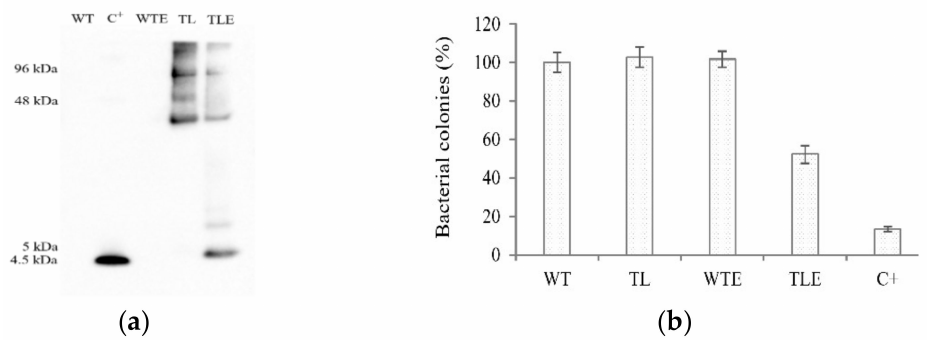
Figure 4. Analysis of the antibacterial activity of rhLL-37. ( a ) Immunoblot analysis of enterokinase- released rhLL-37 peptide purified by amylose resin affinity chromatography from late milk en- dosperm grains (BBCH 77) of MBP::rhLL-37 transgenic T6 generation barley plants. The sizes of individual bands corresponded to the theoretical size of the MBP_rhLL-37 fusion peptide (48 kDa), dimer aggregate (96 kDa), and enterokinase released rhLL-37 (5 kDa), or synthetic LL-37 peptide (4.5 kDa). Proteins from wild type (WT, non-transformed plant) and transgenic line (TL) subjected to enterokinase cleavage are indicated as WTE and TLE, respectively. A total amount of 100 ng synthetic LL-37 (C + ) and 200 ng of recombinant peptides was loaded on the gel. ( b ) Antibacterial activity analysis of the purified samples prepared from late milk endosperm grains (BBCH 77) of T6 generation of transgenic barley. The biological activity was examined with E. coli TOP10, which was mixed with 400 ng of either synthetic LL-37 or rhLL-37. The number of bacterial colonies on agar plates formed in the presence of purified protein extracts from wild type barley grains was considered as 100%. The data represent the means of three independent experiments, each in three technical